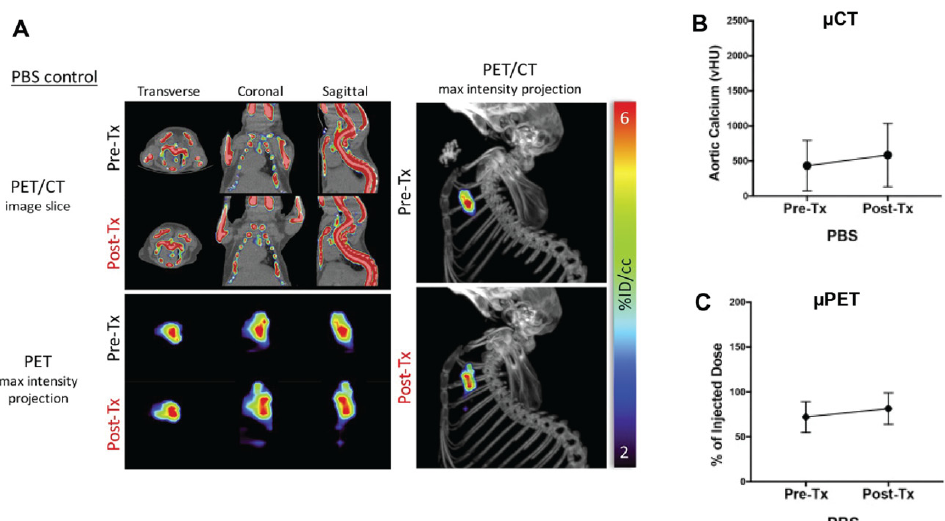
Figure 7. In vivo 18 F-NaF µ PET / CT Imaging. ( A ) Fused µ PET / CT Imaging showing 18 F-NaF uptake (representing calcium mineral surface area) in 12-month old phosphate-bu ff ered saline (PBS)-treated mice, before and after treatment with teriparatide (Tx). Transverse, coronal, and sagittal slices